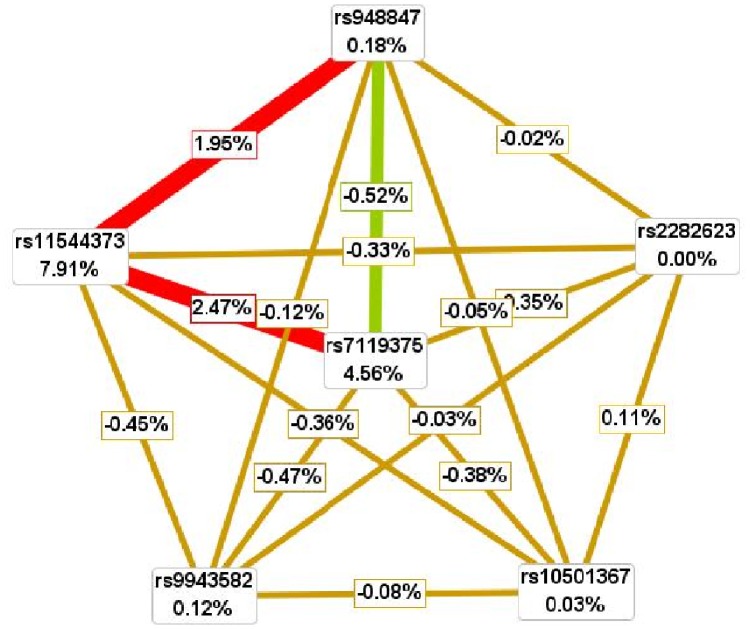
Interaction entropy graph of AGTRL1 gene six examined polymorphisms.